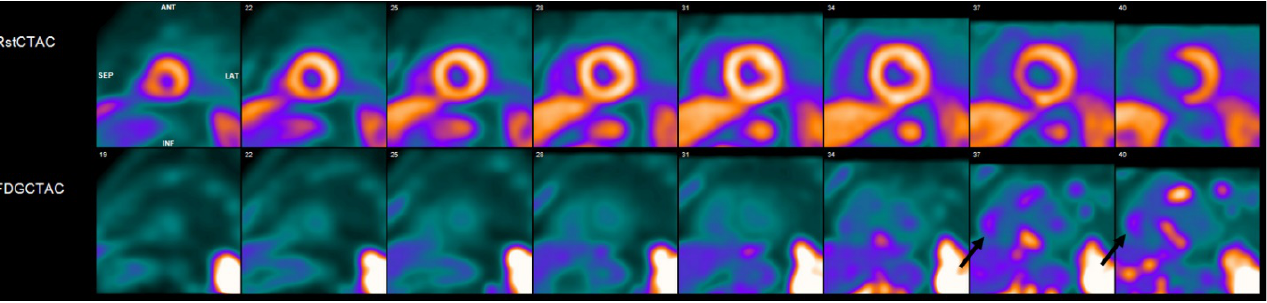
Figure 3. Cardiac positron emission tomography/computed tomography (PET/CT) with 13 N-ammonia (top row) and 18 F- flurodeoxyglycose (FDG) (bottom row) demonstrates a perfusion defect involving the basal septum with corresponding abnormal FDG uptake consistent with an inflammatory process. This patient had biopsy-proven systemic sarcoidosis, with history of complete heart block requiring pacemaker implantation. Findings were therefore felt to be consistent with probable cardiac sarcoidosis. In addition, patient was noted to have abnormal FDG uptake in the right ventricular free wall (black arrows), which portends a worse prognosis.